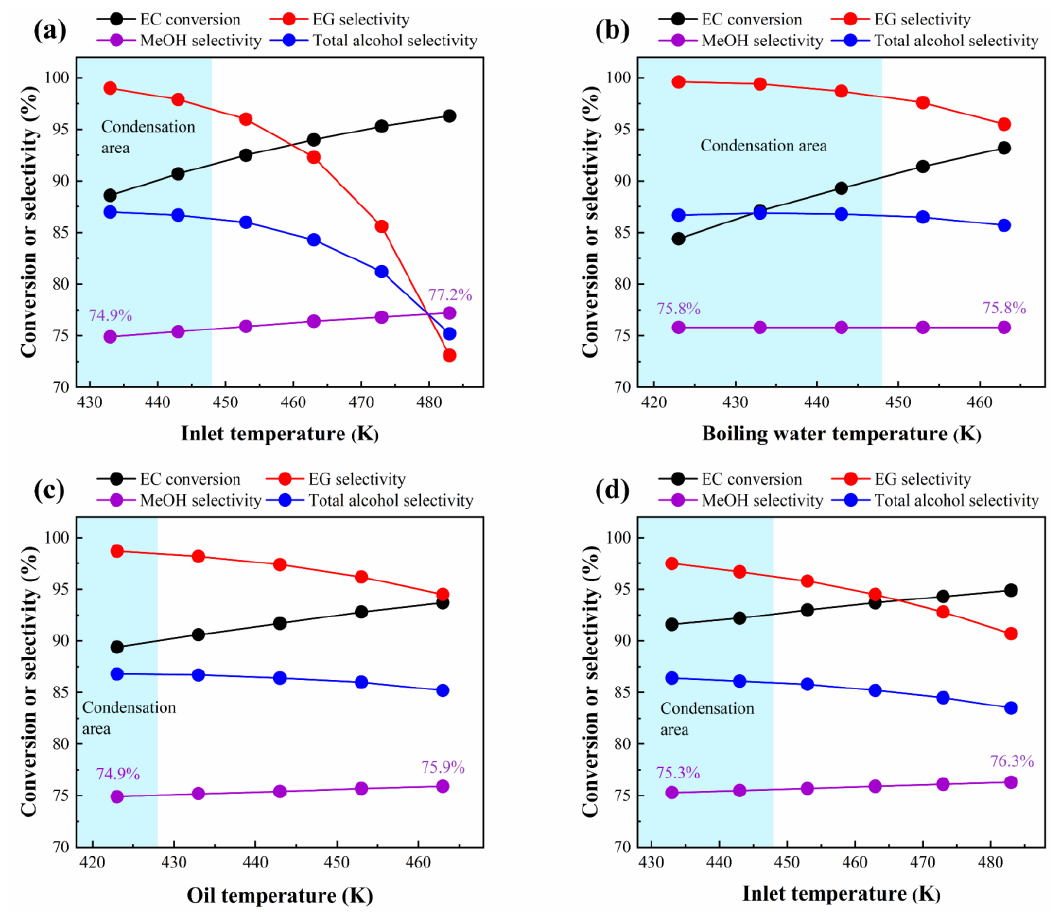
Figure 7. Reactor performance under different reactant/coolant inlet temperatures: ( a ) adiabatic reactor with T in = 433–483 K, ( b ) boiling water-cooled reactor with T in = 463 K and T c = 423–463 K, ( c ) conduction oil-cooled reactor with T in = 463 K and T c = 423–463 K, ( d ) conduction oil-cooled reactor with T c = 463 K and T in = 433–483 K. Operating conditions: 3 MPa, 0.3 g EC · gcat − 1 · h − 1 , H 2 /EC = 200.